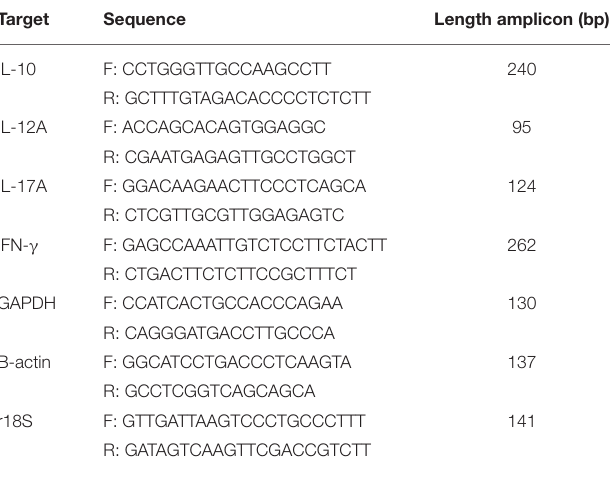
TABLE 2 | List of primers for